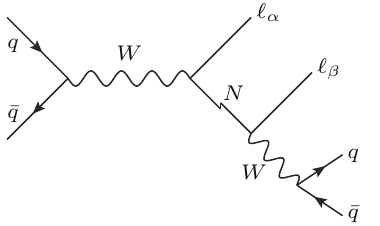
Fig. 1 Drell–Yan HNL production leading to a dilepton signature. The thunder-shaped arrow indicates that the HNL could be of Dirac or of Majorana nature, short- or